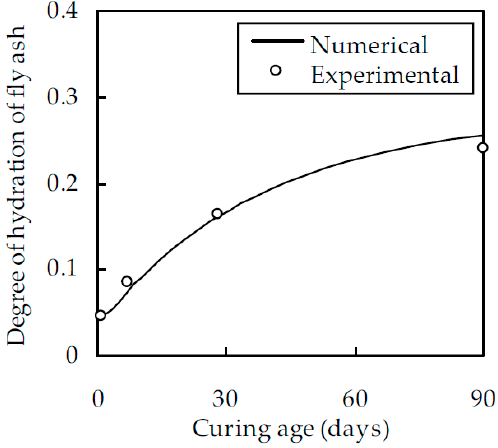
Figure 1. A comparison between the numerical estimate and experimental results of Haha et al. [34].